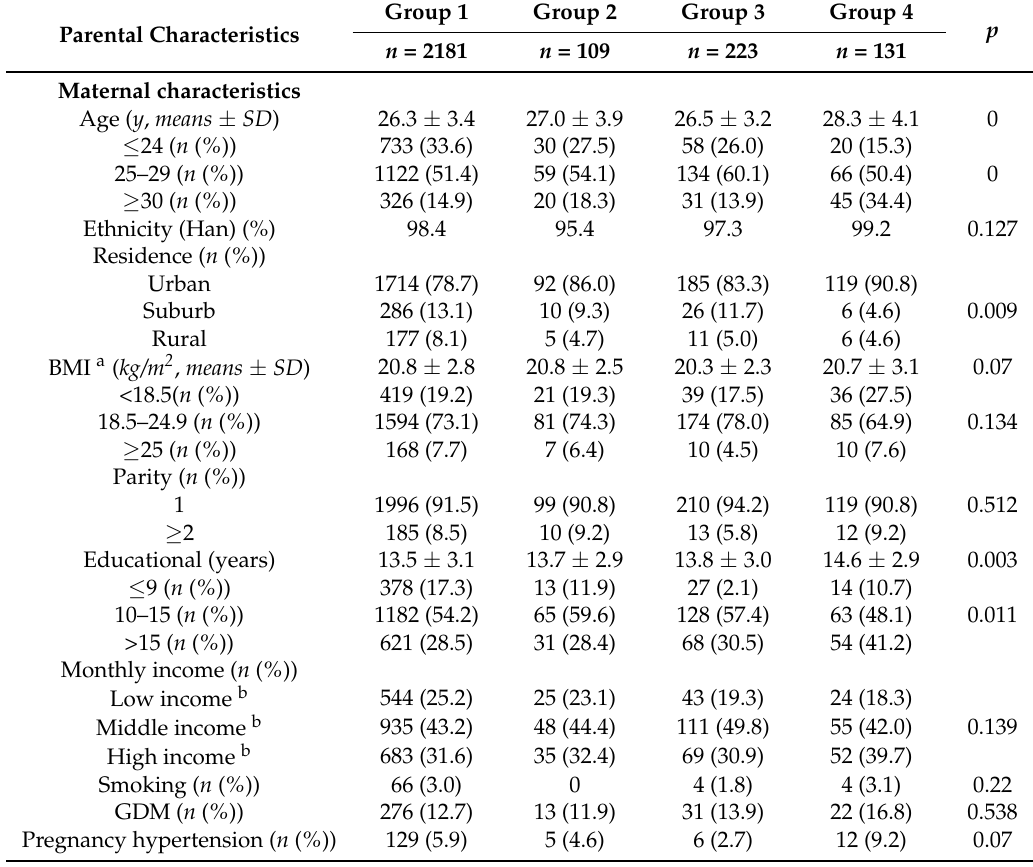
Table 1. Parental characteristics according to FA supplement use after the first trimester of pregnancy.